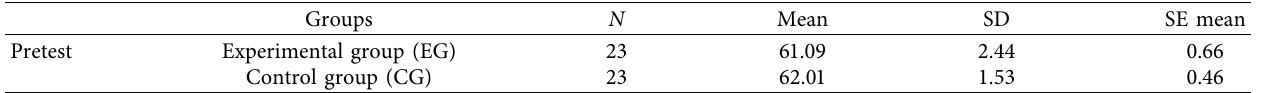
Table 4: Pretest descriptive statistics.